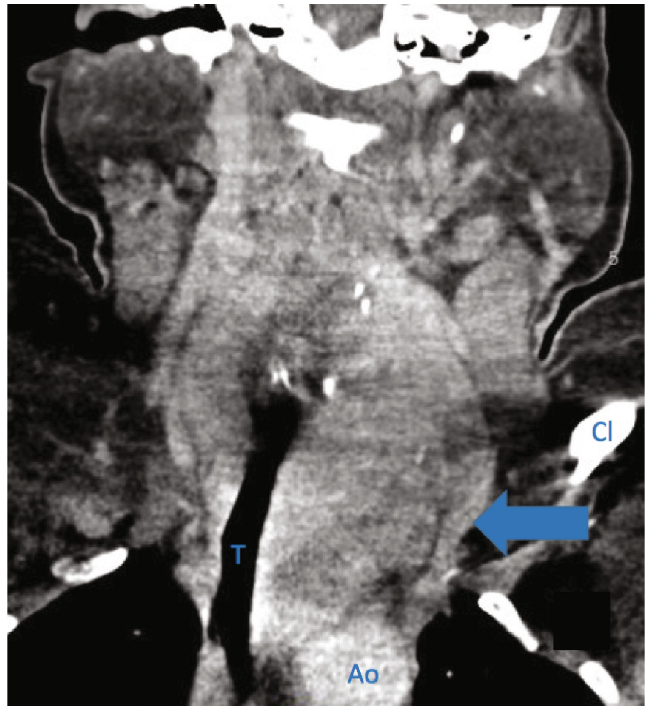
Figure 1: CT neck soft tissue with contrast showing bilateral thyroid goiter with substernal left thyroid extension (blue arrow), rightward tracheal deviation, and mild narrowing. Labels in picture: T: trachea; Ao: aorta; Cl: